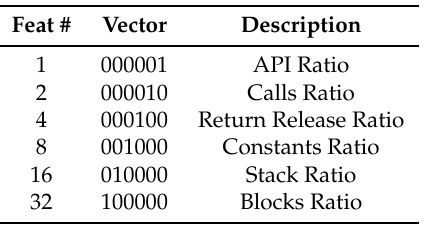
Table 5. Numbering of Feature Combination